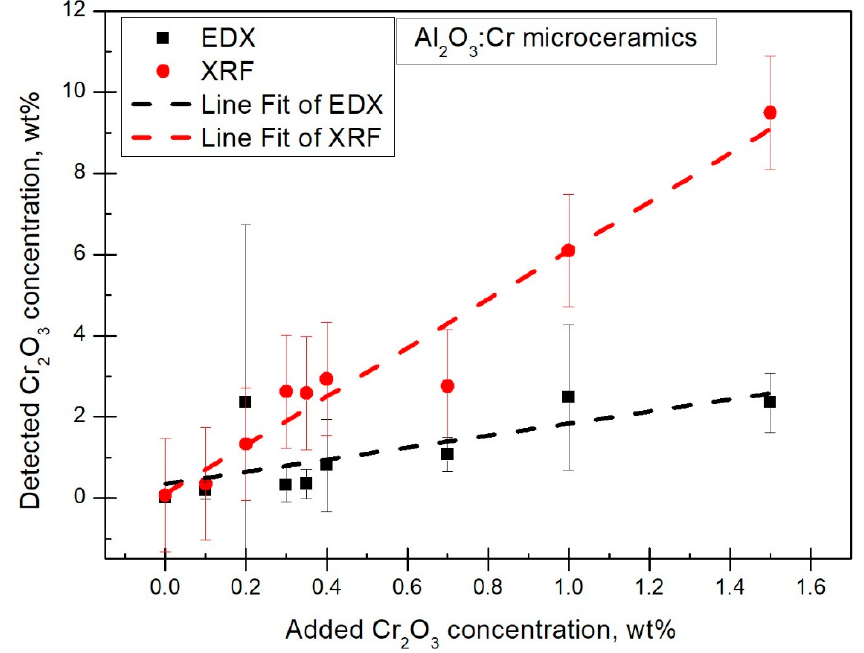
Figure 2. EDX and XRF results.